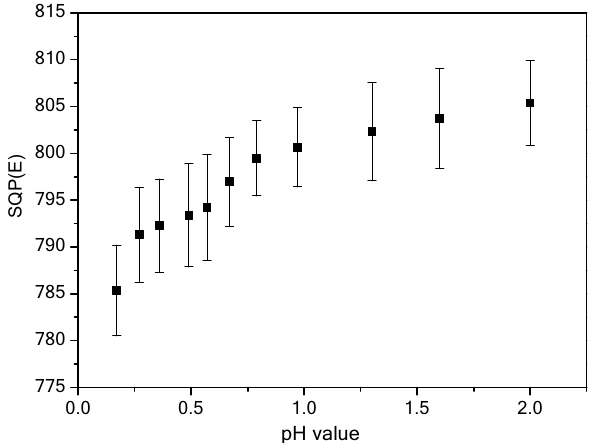
Figure 2. Variation curve of SQP(E) value at different pH values in HNO 3